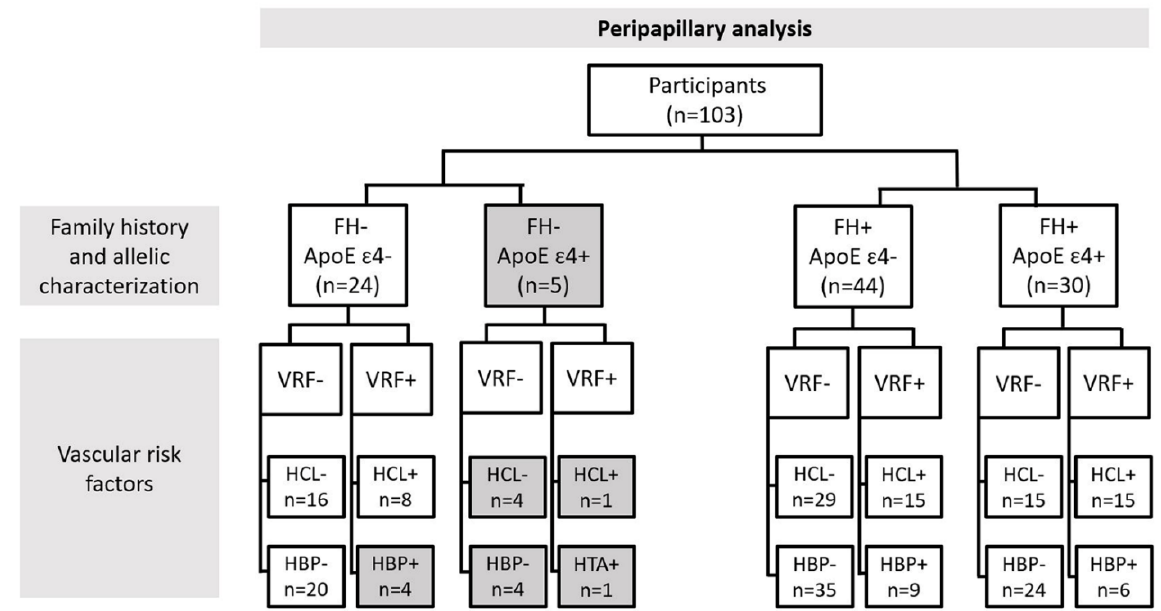
Figure 2. A flow diagram of the study groups according to the different characteristics for which the vascular network of the peripapillary area was analyzed: FH: family history of AD; ApoE: Apolipoprotein E; VRF: vascular risk factors; HCL: hypercholesterolemia; HBP: high blood